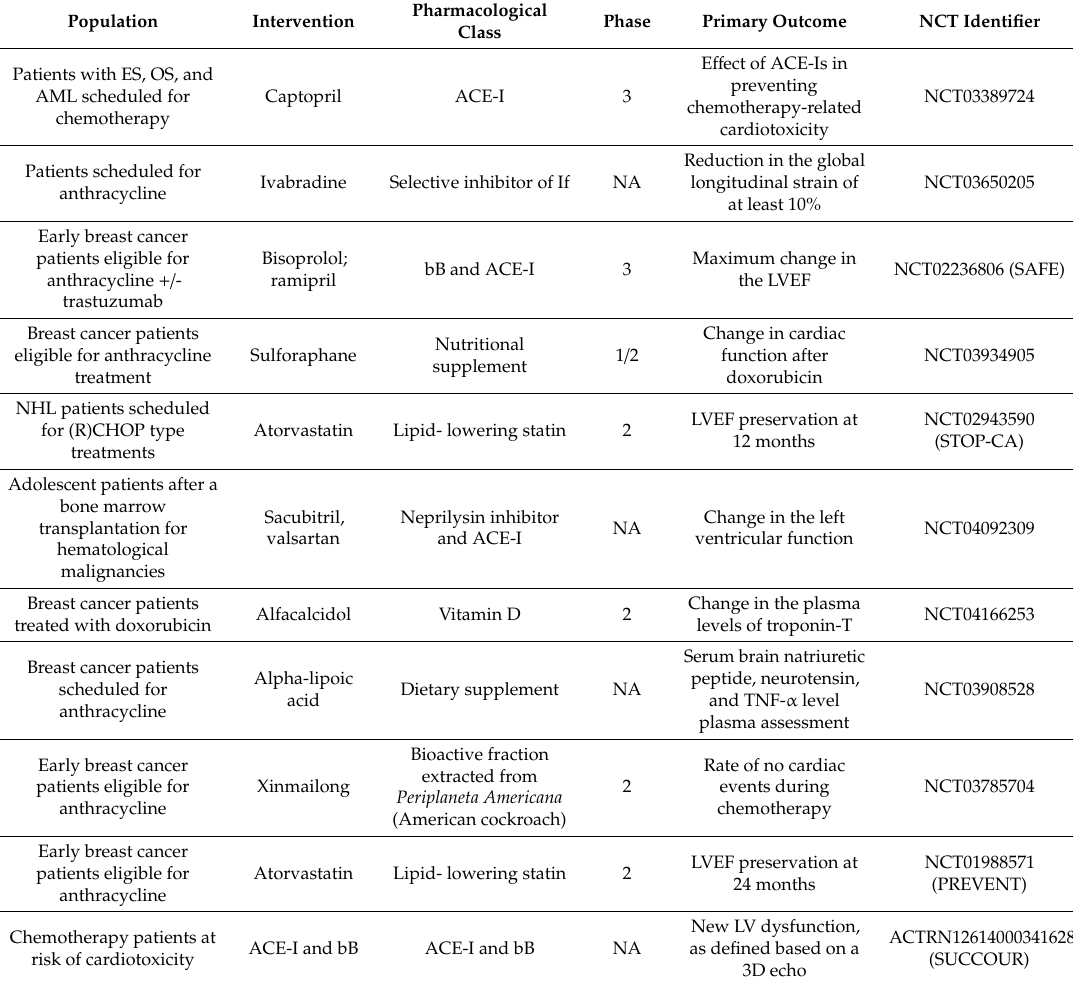
Table 2. An overview of the ongoing clinical trials of cardio-protective agents with patients receiving anticancer